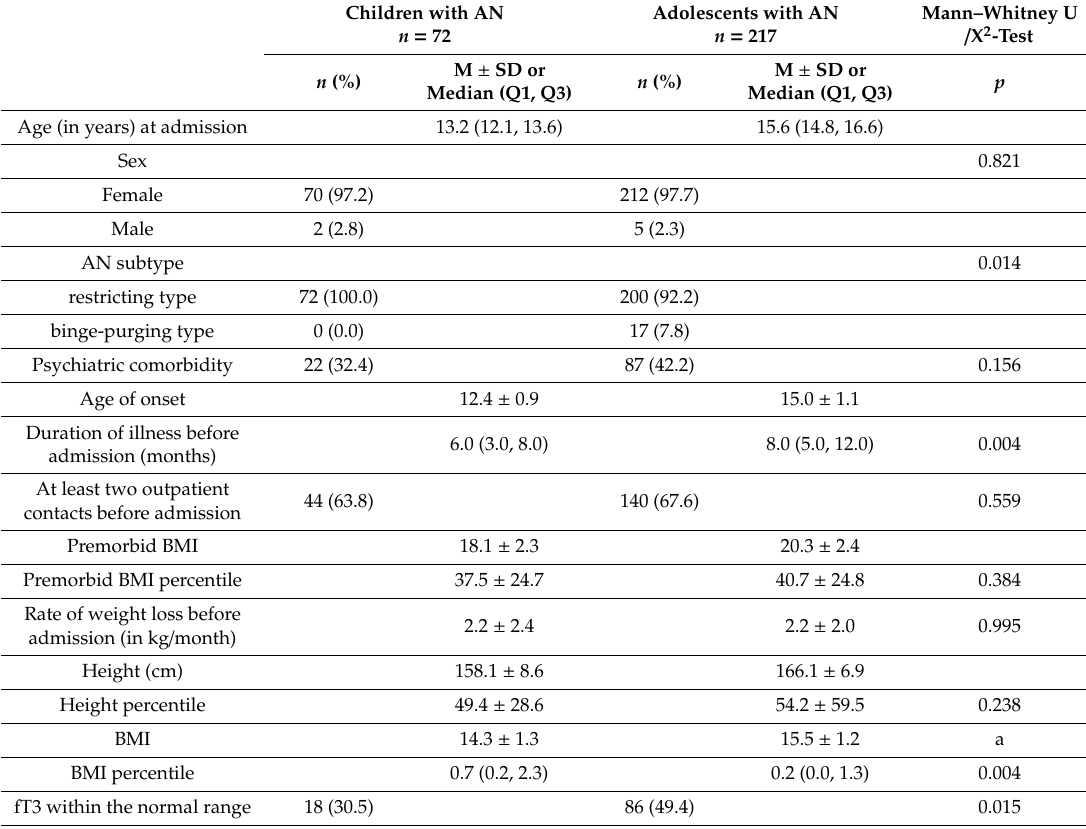
Table 1. Clinical characteristics at admission.